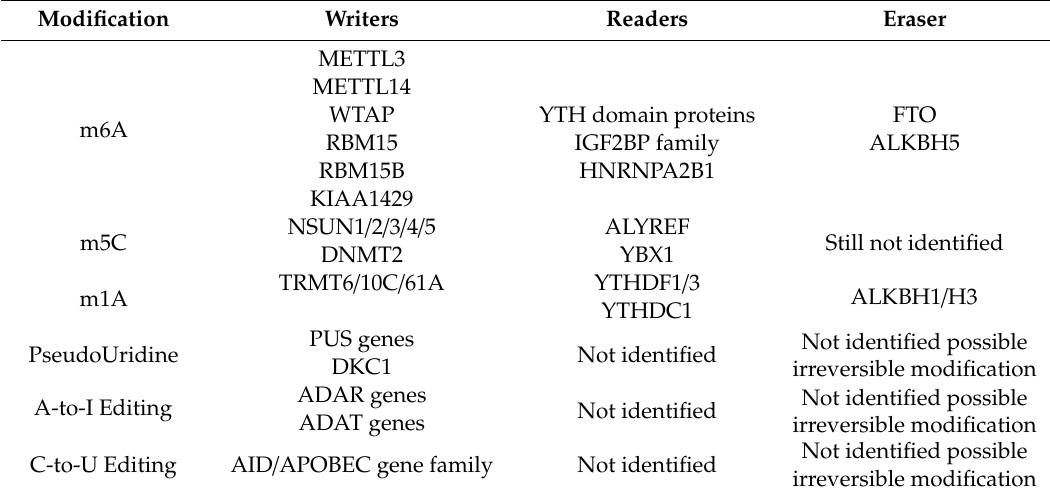
Table 1. Principal epitranscriptomics